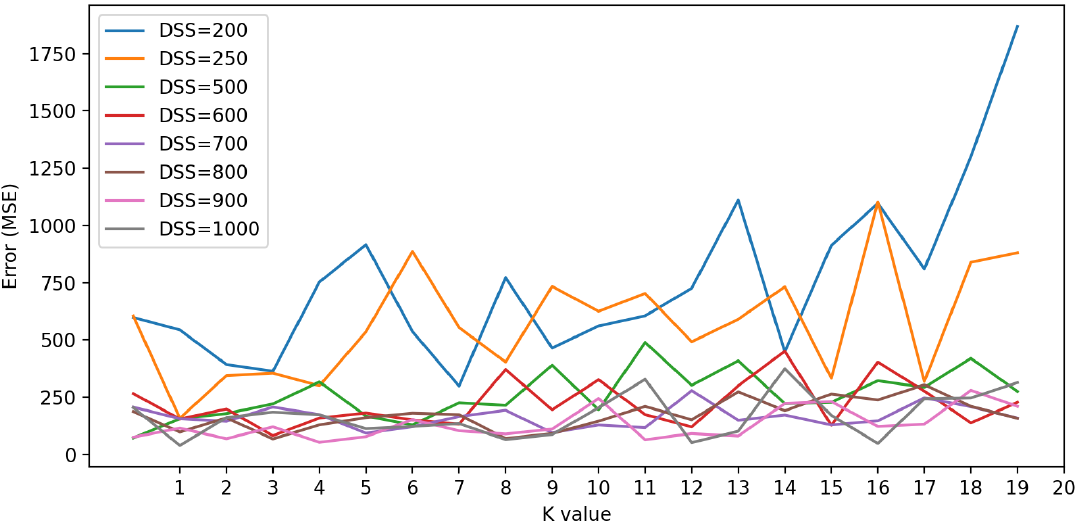
Figure 8. Errors for different dataset size (DSS) with different K values.